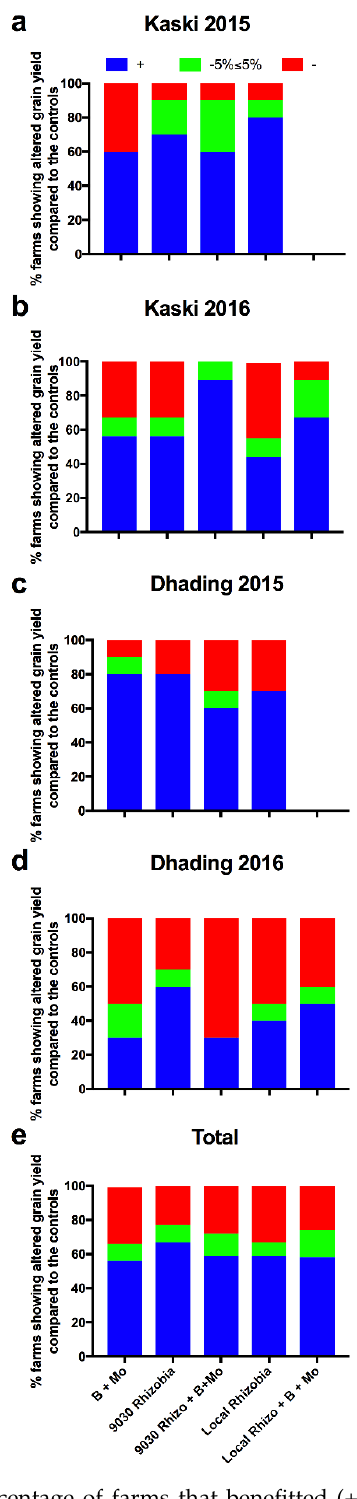
Figure 4. Summary of the percentage of farms that benefitted (+), were negatively affected ( − ), or experienced no effect ( − 5% ≤ 5%) for grain yield, from the rhizobium/micronutrient treatments compared to the respective internal control plots (uninoculated and without micronutrients) at ( a ) Kaski-2015, ( b ) Kaski-2016, ( c ) Dhading-2015, ( d ) Dhading-2016, and ( e ) the total across all 4 trials. The percentage of farms showing altered grain yield = (# of farms that had positive, negative, or neutral effects/total # of farms) × 100%.